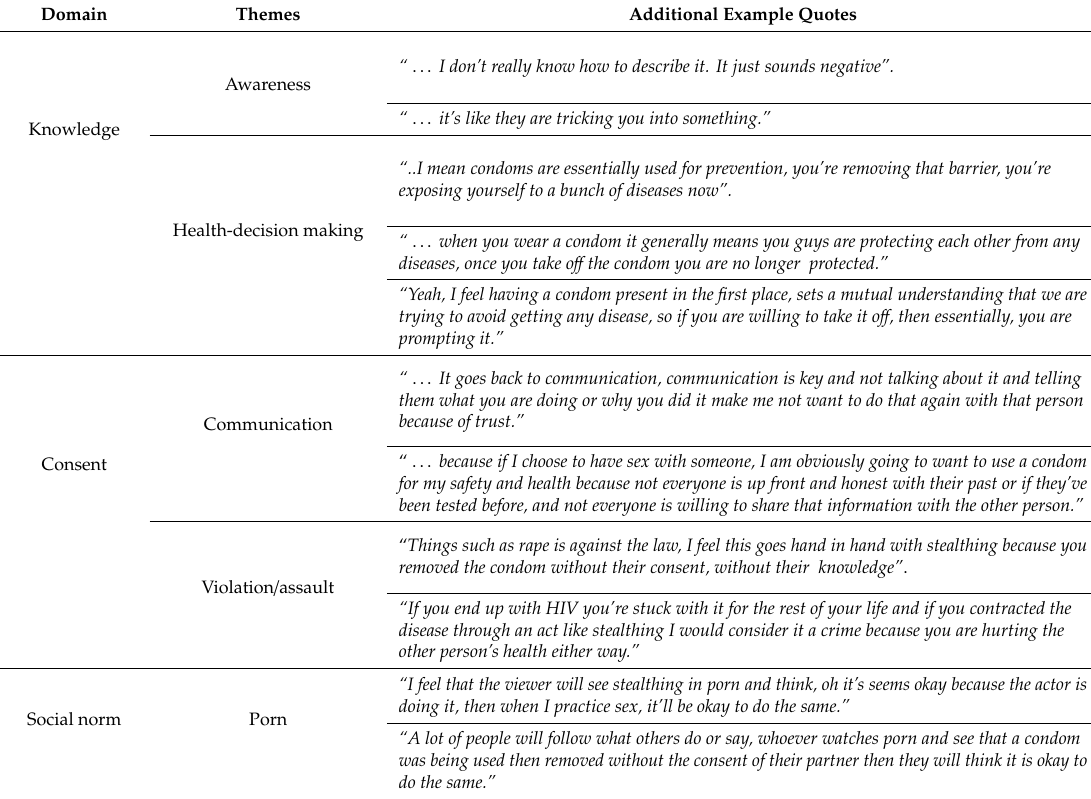
Table 1. Identified themes and associated domains from focus group